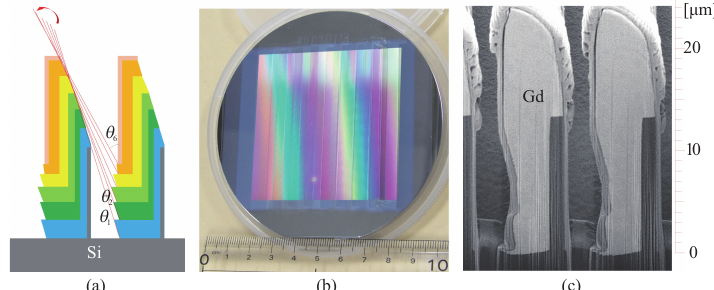
Figure 11. Gd absorption grating fabricated by inclined evaporation [89]: ( a ) Illustration of Gd deposition by repleting evaporation at every step of Si grating shift. The geometrical direction of the Gd source changes by the shifts. ( b ) Photograph of a Gd grating with an area of 64 mm × 64 mm. ( c ) Image of scanning electron microscopy obtained for a section of Gd grating made by a focused ion beam.